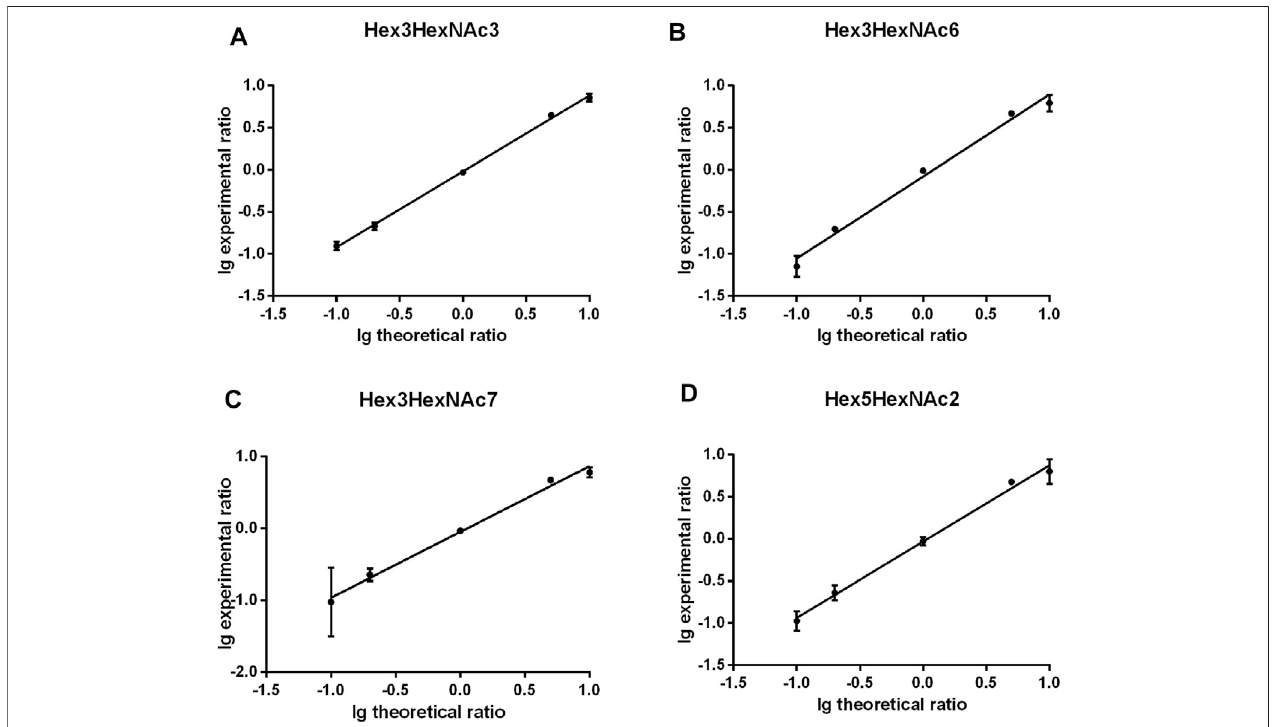
FIGURE3| ComparisonofgQuantthereportedratiowithexperimental mixedratios(rangingfrom10:1,5:1,1:11:5,and1:10)offourglycans. (A) Hex3HexNAc3, (B) Hex3HexNAc6, (C) Hex3HexNAc7 and (D) Hex5HexNAc2.